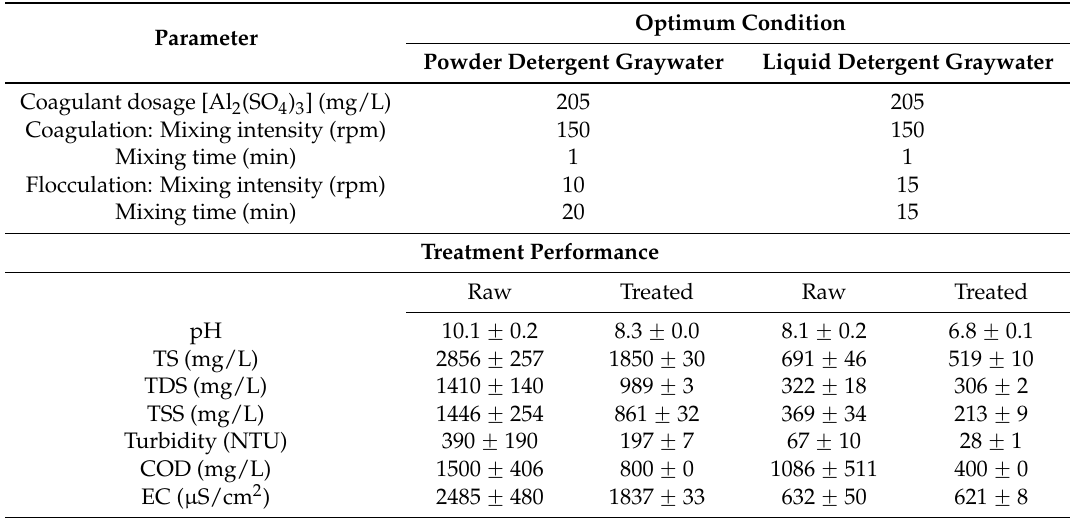
Table 3. Optimum conditions for the graywater coagulation–flocculation